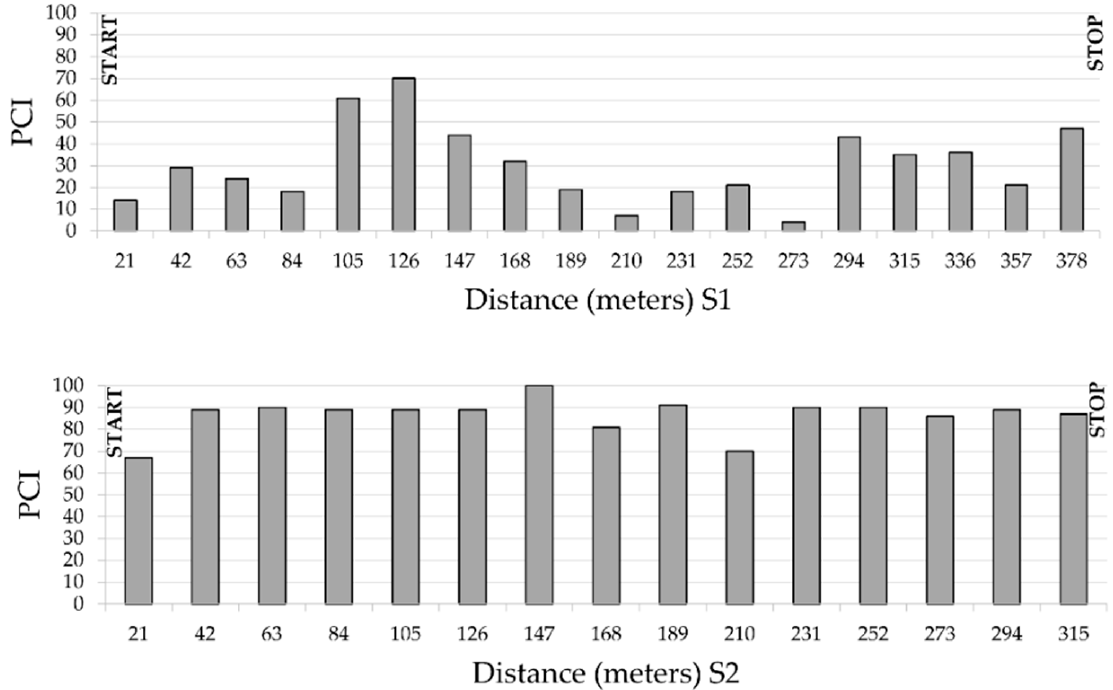
Figure 4. PCI value of sample units and sections, calculated according to ASTM D 6433-11. (Section Ta1 L = 378 m W = 11 m, Section Ta2 L = 315 m W = 7 m. Pavement type = asphalt).